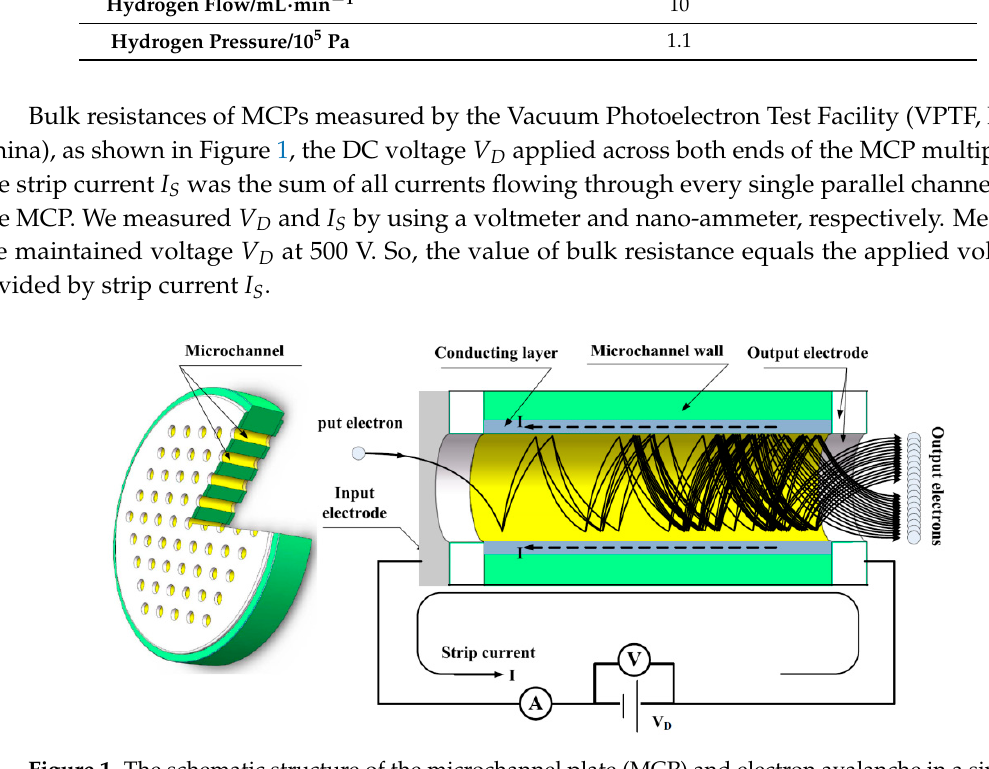
Figure 1. The schematic structure of the microchannel plate (MCP) and electron avalanche in a single channel. An incident electron strikes the input surface of a microchannel and produces one or more secondary electrons. The voltage V D applies across both ends of the MCP, the strip current I s follows through the conducting layer in the channel wall and supplies the current released from it.